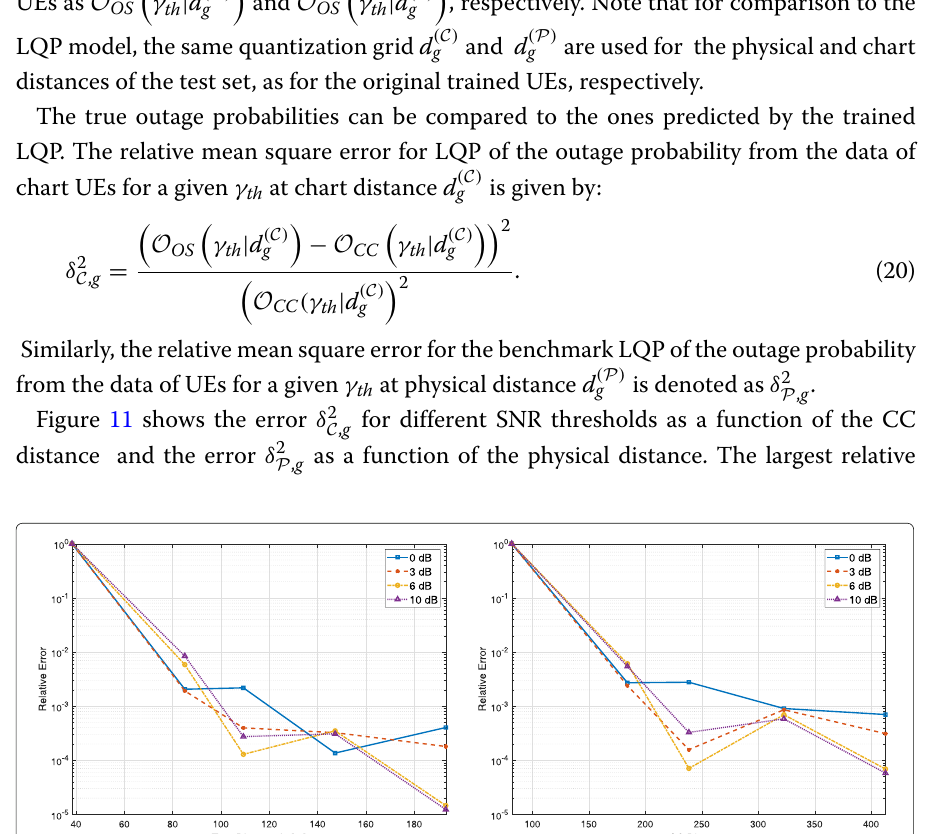
(left plot) and δ 2 C (right plot). The small values of δ 2 P , g , g